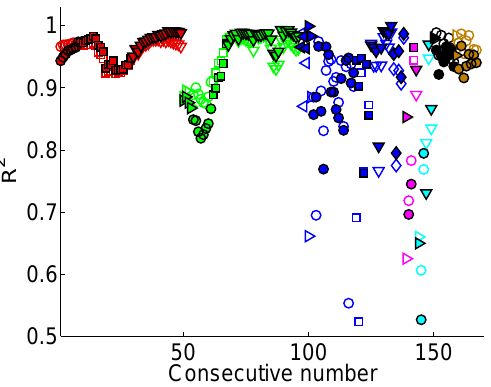
Figure 6. Scatter plot of the SHS diameter estimate ˆ d and the opti- cal diameter d opt . Experiment series are indicated by colors (TGM- 17: red, TGM-2: green, DIV: blue, DH-1: magenta, DH-2: cyan, ISO-1: black, ISO-5: brown) and snow types by markers (PP: (cid:67) , DF: (cid:66) , RG: ◦ , FC: (cid:3) , DH: ∨ , MF: (cid:5) ). The black solid line indi- cates the 1:1 relation.